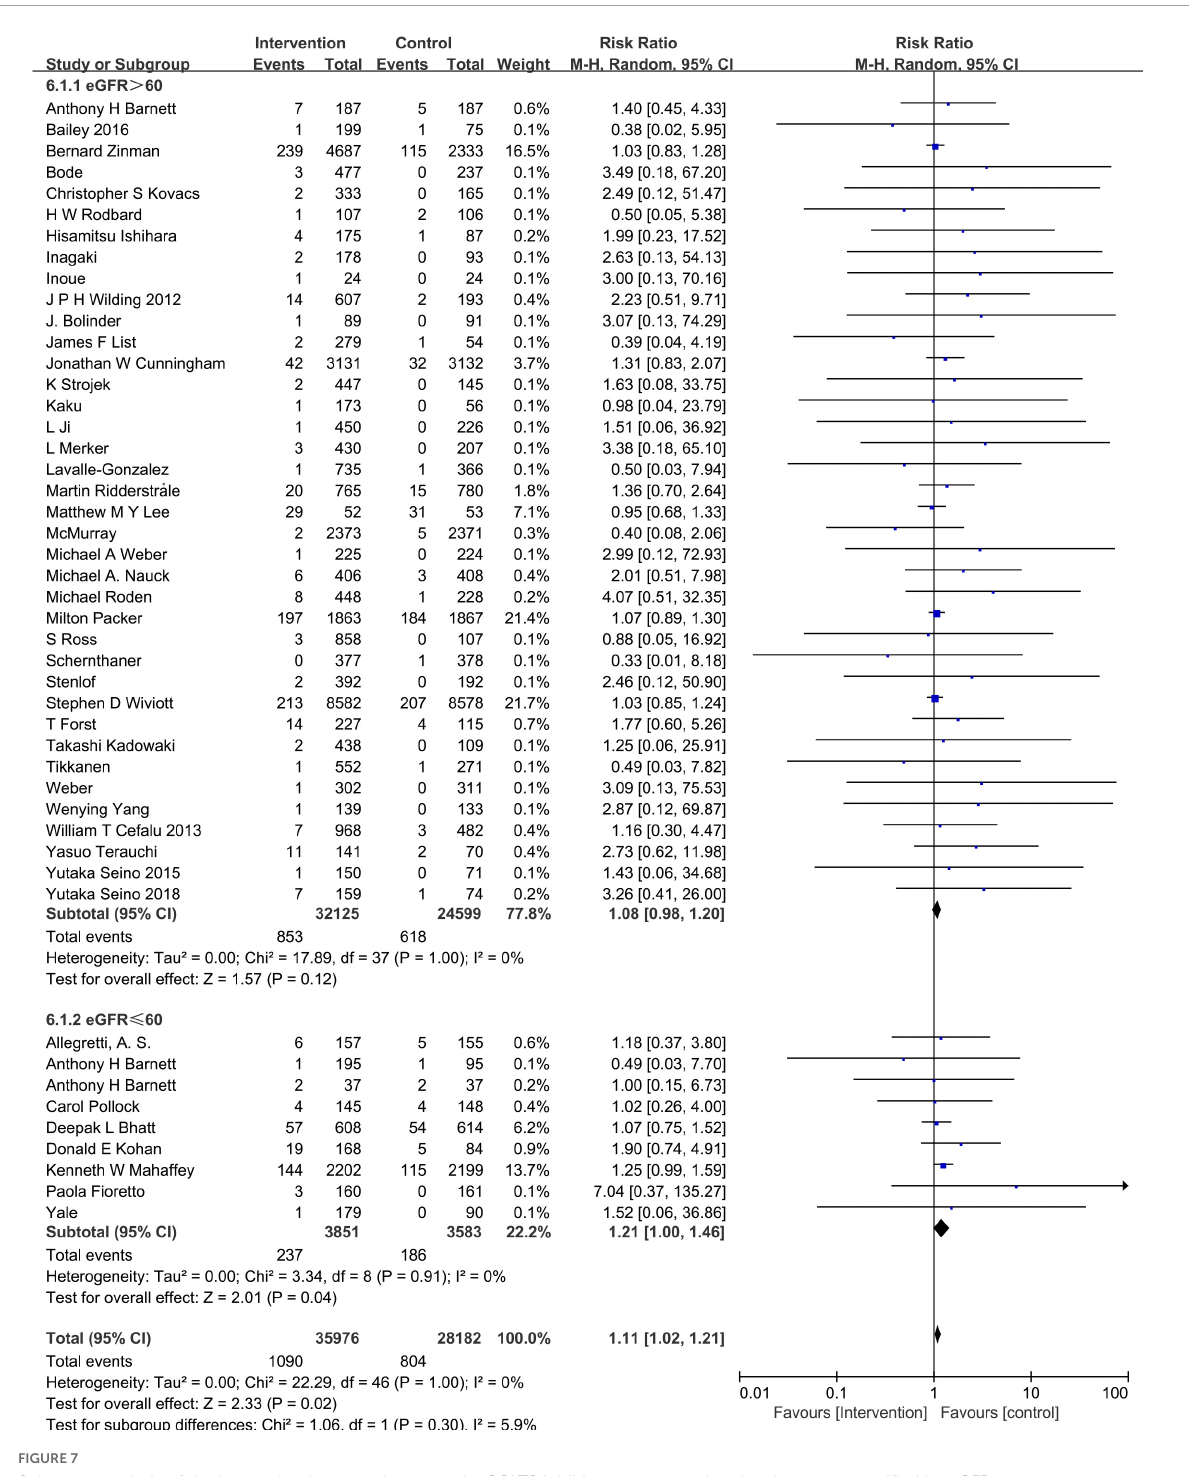
is an exquisite skill, hypovolemia in HF patients may be detrimental (70). Our meta-analysis unveils the increasing risk of hypovolemia associated with SGLT2 inhibitors, if